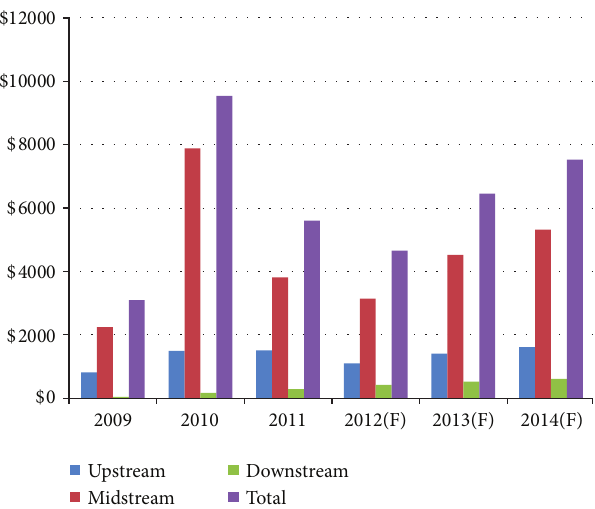
Figure 1: Revenue of Taiwanese solar photovoltaic industry. Upstream:siliconmaterial;Midstream:solarcell(wafer-based;thin- film) and solar cell module; Downstream: solar photovoltaic system. Source: adapted from PIDA (2012) [1].